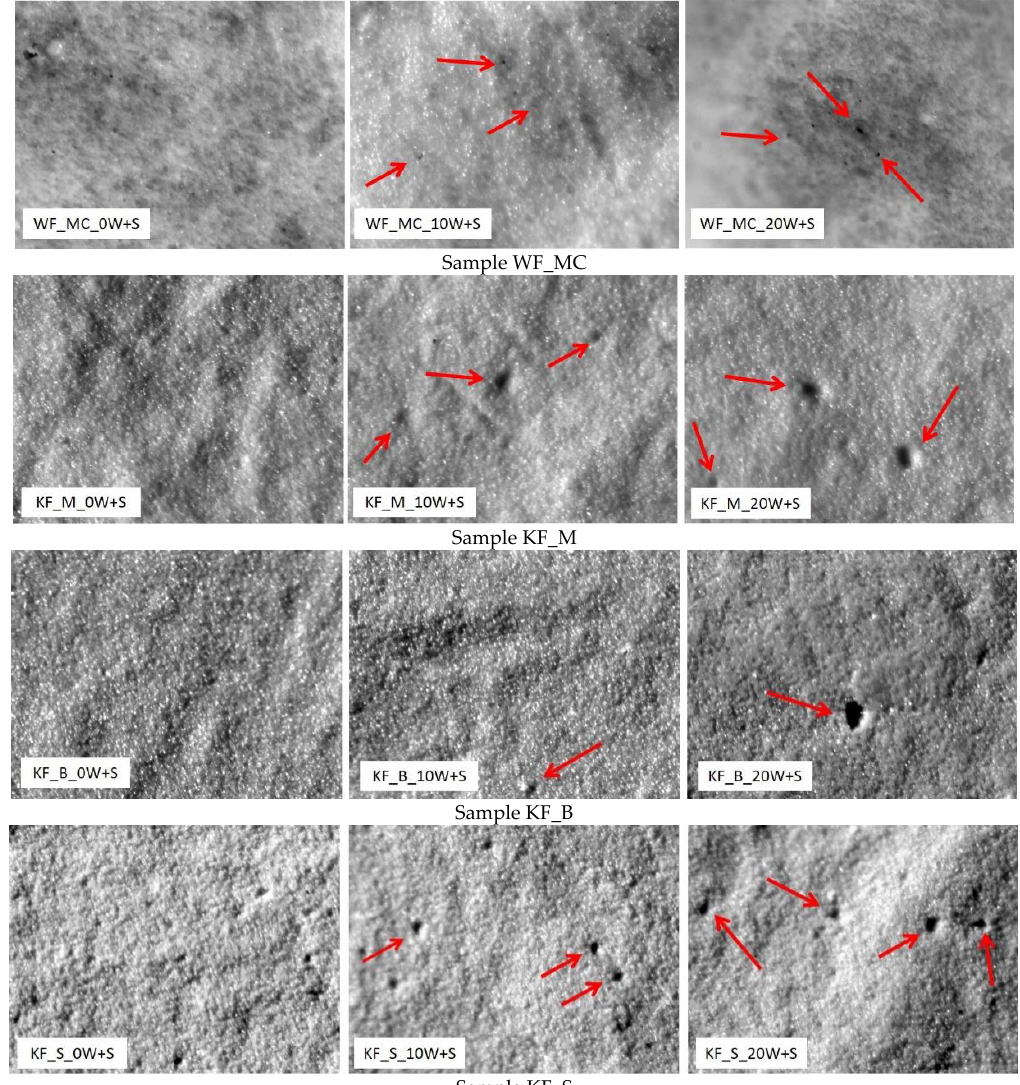
Figure 5. Microscopic analysis of the polyurethane coating, magnification 128×.